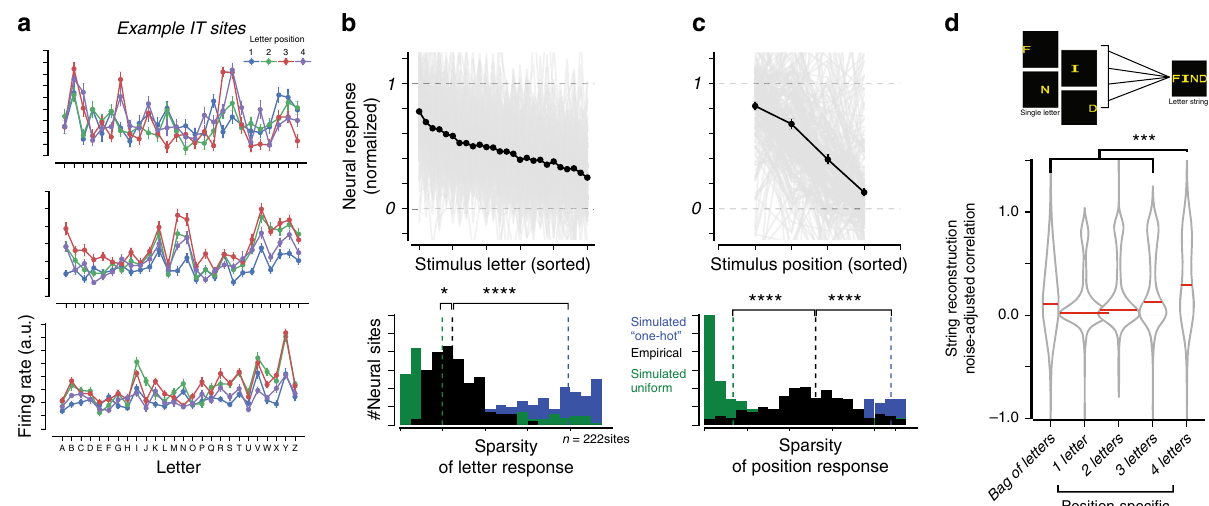
Fig. 4 Encoding properties of single IT sites. a Firing rate responses to individual letter stimuli (26 letters at four positions) for three example IT sites. Error bars correspond to SEM across stimulus repetitions ( n > 30 repetitions per image). b (top) Gray lines indicate the normalized mean response to each of the 26 letters, sorted (using an independent half of the data) for each of 222 IT neural sites. The black line indicates the population average (mean ± SE across sites, n = 222 sites; note that SE is very small). Neural sites reliably respond more to some letters than others. However, this modulation is not very selective to individual letters or small numbers of letters, as quanti fi ed by the sparsity of letter responses (bottom panel). c Individual sites were also modulated by the letter position, exhibiting tolerance across positions (formatted as in b ). d To test if the encoding of letter strings can be approximated as a local combination of responses to individual letters, we reconstructed letter string responses from letter responses (using linear regressions, cross- validating over letter strings), for each neural site. The violin plots show the distribution of noise-adjusted correlation of different regression models ( n = 222 neural sites); the red line corresponds to the median of each distribution. The “ bag of letters ” model uses responses of each of the four letters, at arbitrary positions, as predictors. Each of the position-speci fi c models uses the responses of up to four letters at the appropriate position as predictors. Across all panels, asterisks are de fi ned as: * p < 0.05, ** p < 0.01, *** p < 0.001, **** p < 0.0001 obtained by permutation test of median